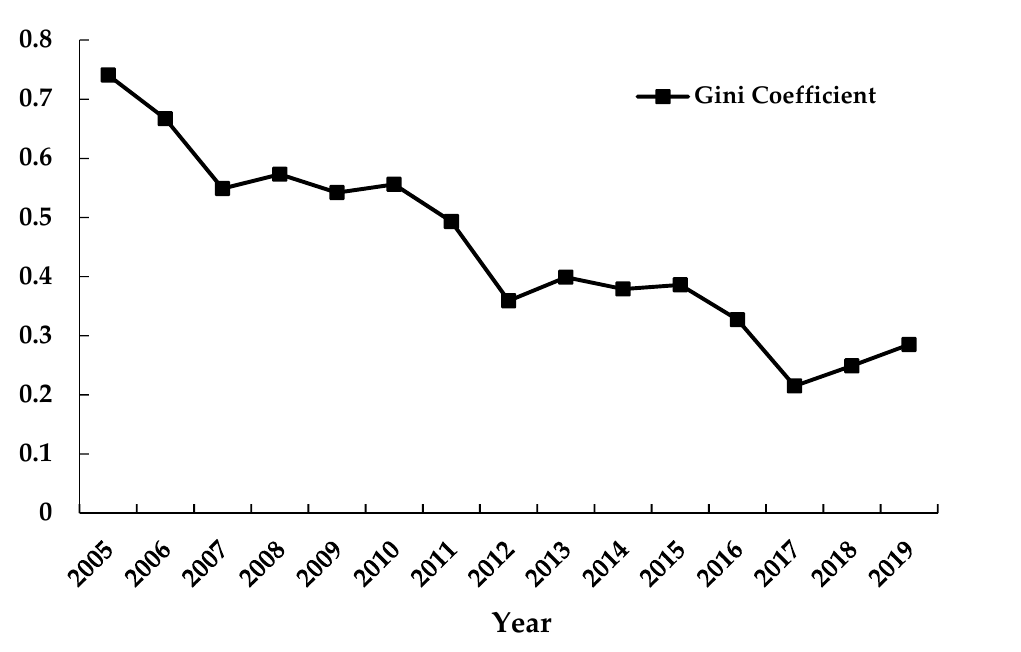
Figure 5. Change process of the Gini coefficient (2005–2019).